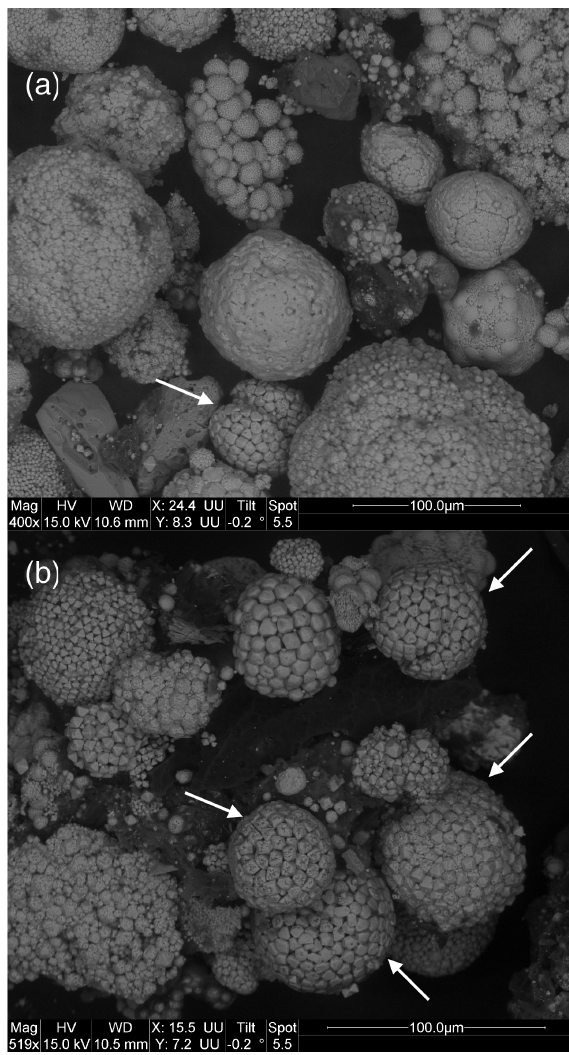
Figure 5. SEM images showing that the framboids yielding perfo- rated microcrystals ( a , white arrow) as well as the perforated micro- crystals themselves fall in a rather narrow size range, compared to the other types of framboids observed in each rock sample (b)